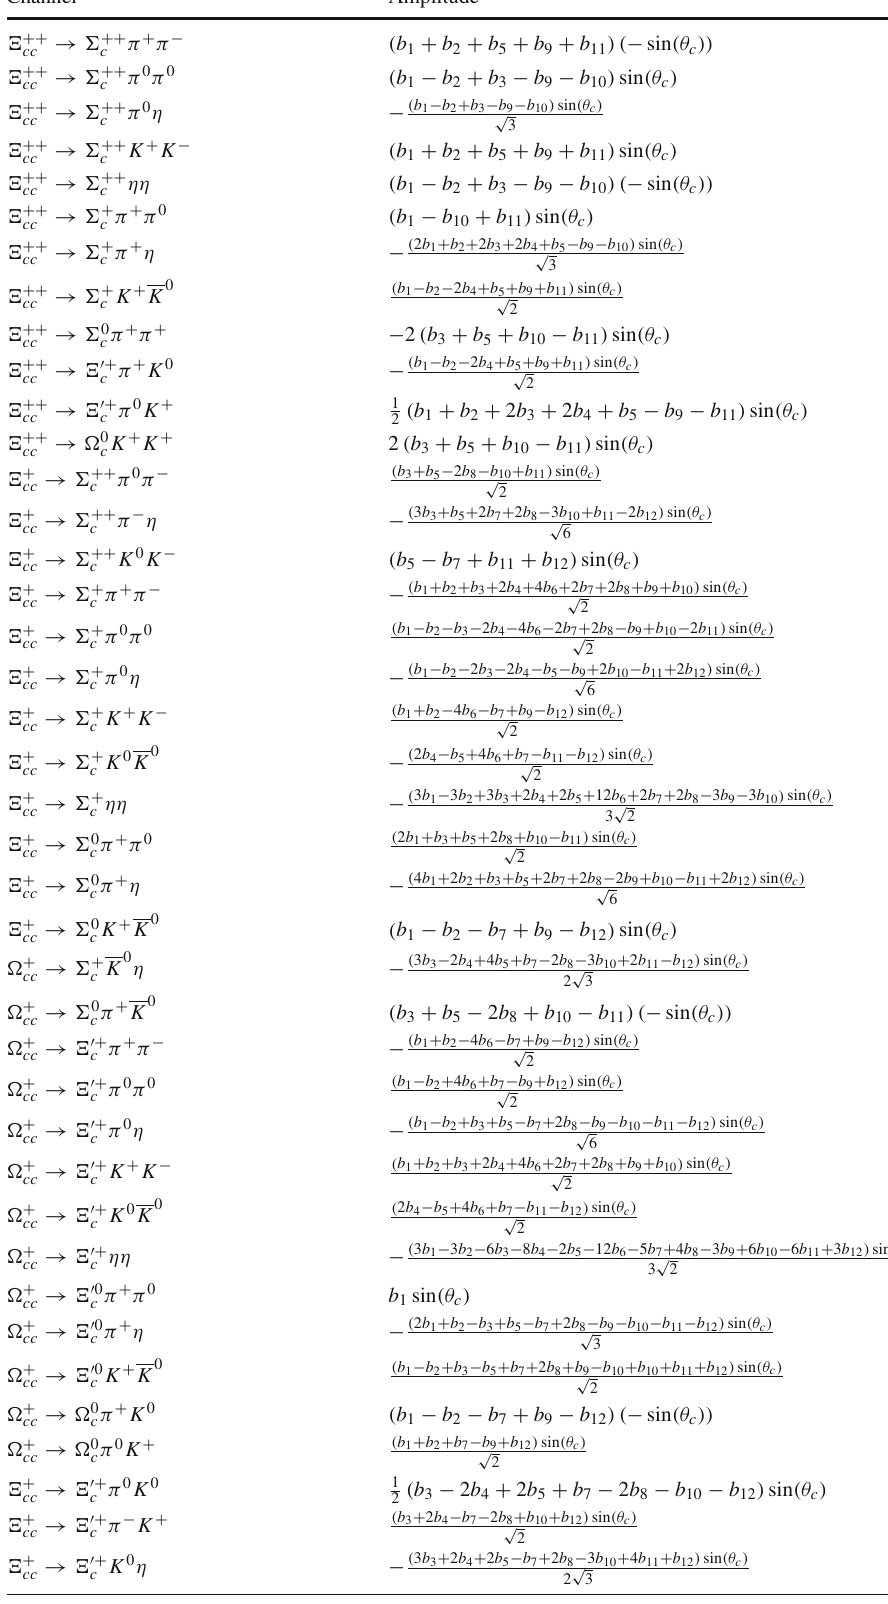
Table 9 Doubly charmed baryon decays into a sextet cqq and two light